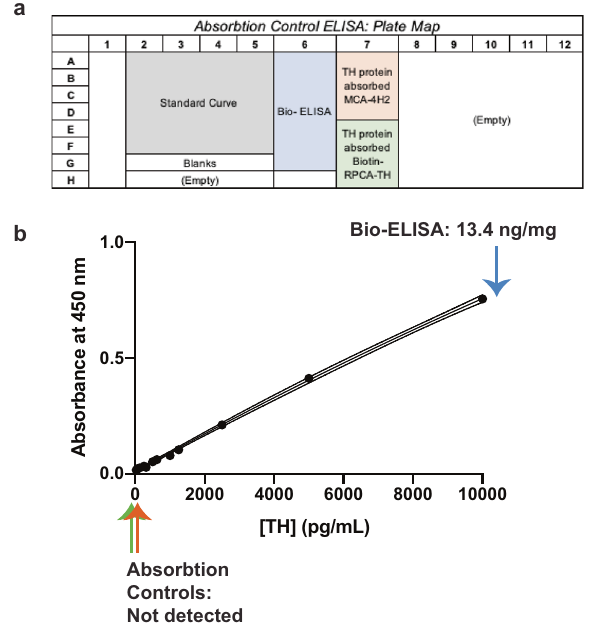
Fig. 4 Absorption controls demonstrate the speci fi city of TH Bio- ELISA. a Schematic layout of experimental conditions to assess absorption controls in contrast to optimized Bio-ELISA conditions using PC12 cell lysate. b Representative standard curve shown to illustrate PC12 cells ’ TH concentration using optimized Bio-ELISA (blue arrow), absorbed capture antibody (MCA-4H2 preincubated with 20 µg/mL recombinant TH, orange arrow), and absorbed detection antibody (biotinylated RPCA-TH preincubated with 20 µg/mL recombinant TH, green arrow). PC12 TH is undetectable after absorption of either capture or detection antibodies, con fi rm- ing assay speci fi